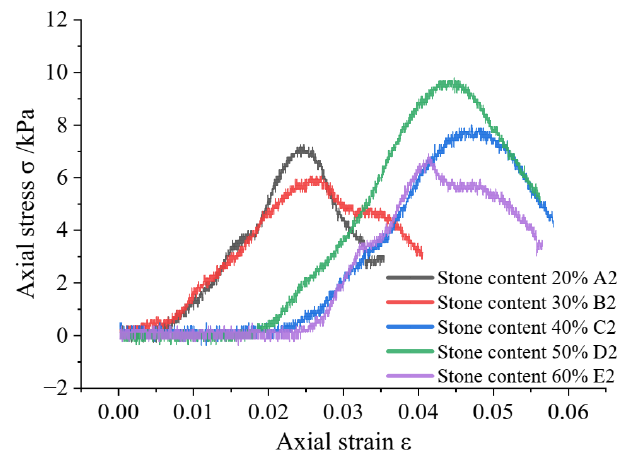
Figure 4. Stress–strain curve of soil–rock mixture stone with particle sizes of 0.4–0.6 cm.